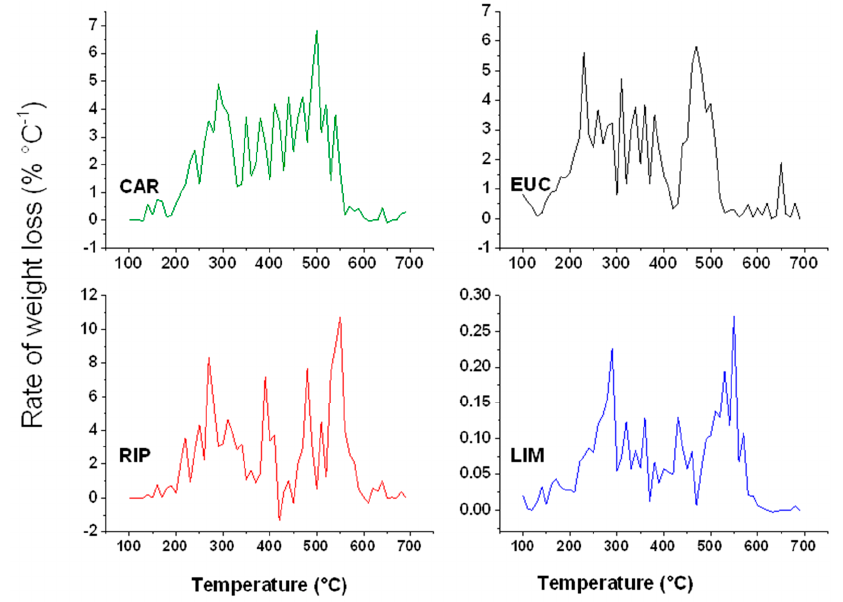
Figure 4. Thermograms of water-soluble lignins isolated from cardoon (CAR), eucalyptus (EUC), black poplar grown in Ripiti (RIP) and black poplar grown in Limatola (LIM) by an alkaline oxidative extractant.